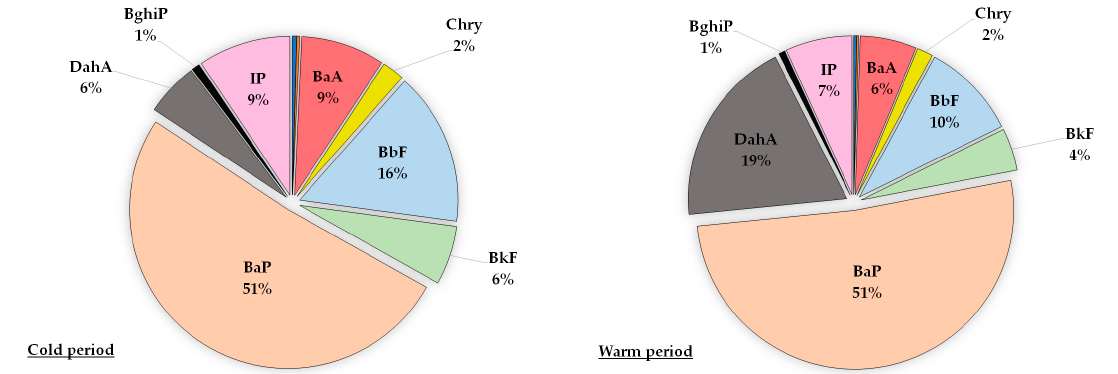
Figure 3. Contribution of individual PAHs to the total carcinogenic activity for bulk deposition samples during the cold and warm periods. Contributions of Flu and Pyr were less than 1%.